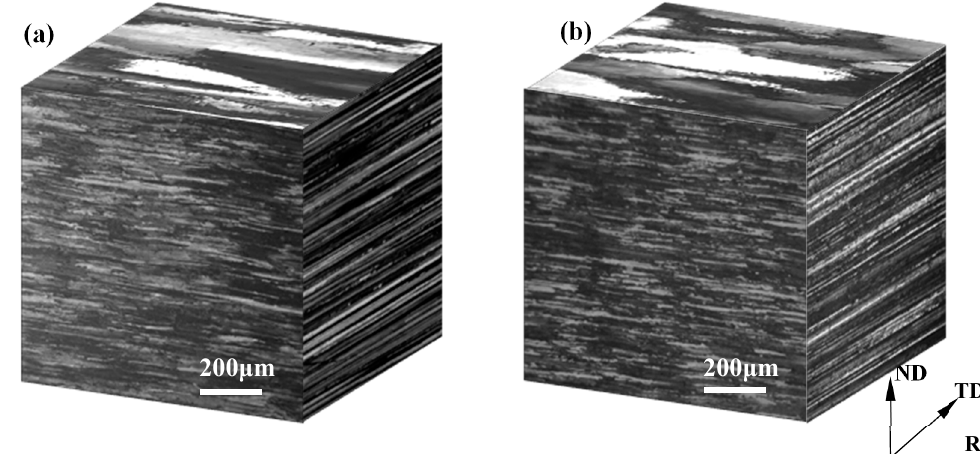
Figure 4. Optical micrographs of AA2195 specimens: ( a ) non-pre-stretching and ( b ) pre-stretching 2%.